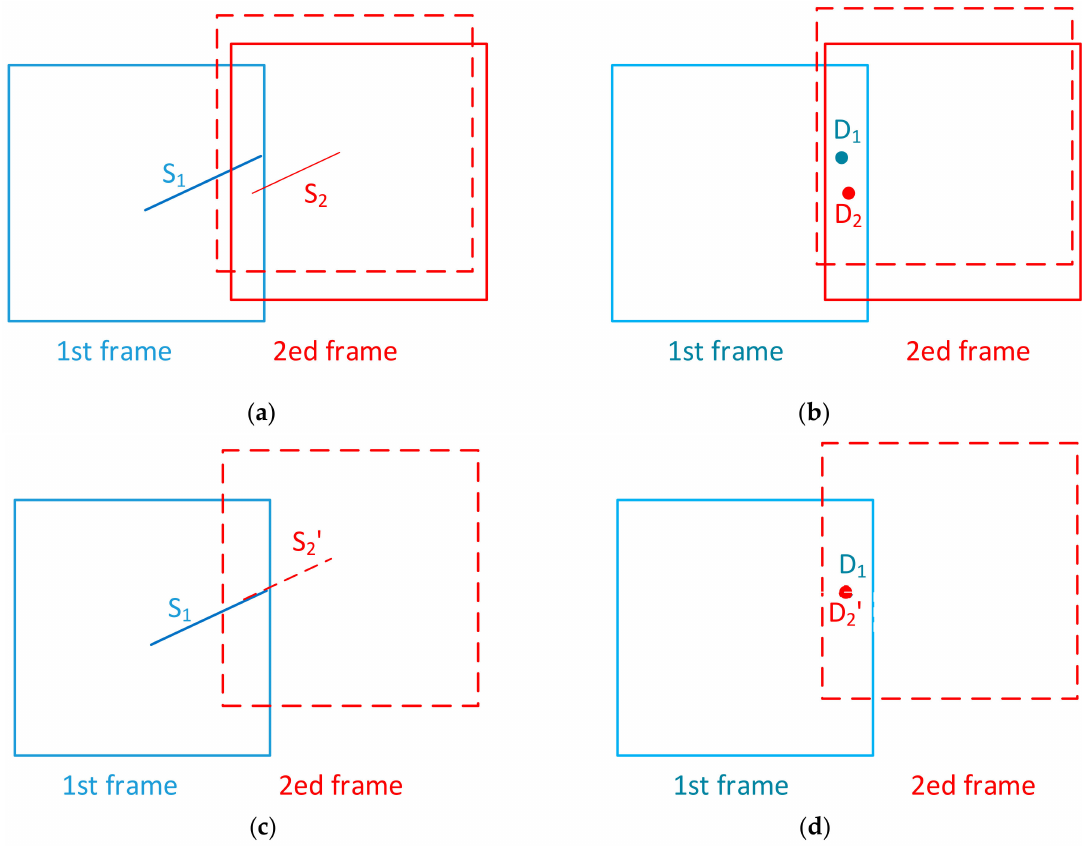
Figure 5. Mismatches that decrease the number of defects. ( a ) Actual scratch; ( b ) Actual dig; ( c ) Mismatch for scratch; ( d ) Mismatch for dig.